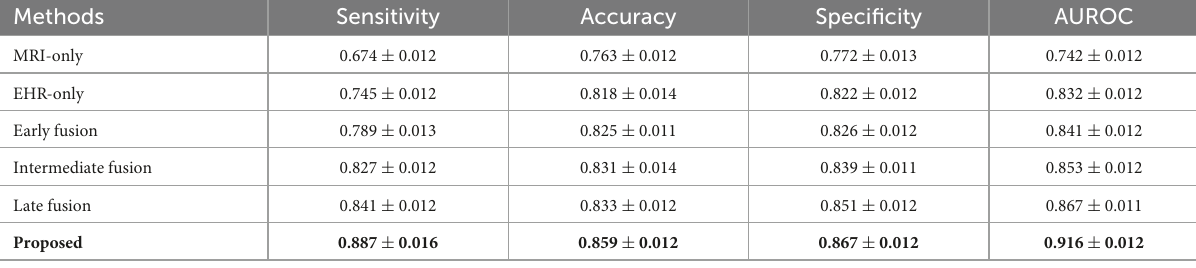
TABLE 3 Performance comparison of the MRI-only method, the Electronic Health Records (EHR)-only method, the early fusion method, the intermediate fusion method, and the late fusion method on the test diabetes mellitus (DM) dataset.